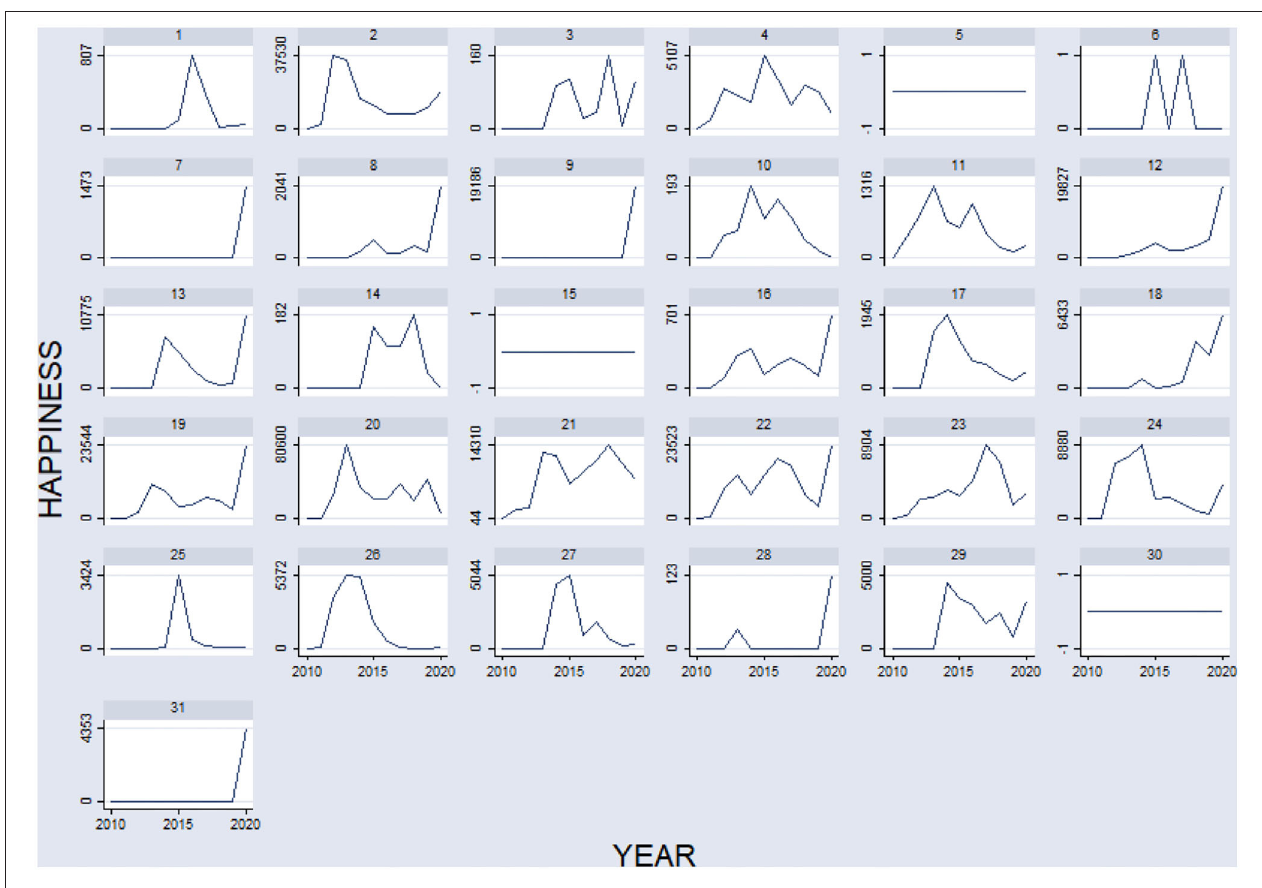
FIGURE 4 | Change of happiness among 31 provinces over 2010–2020.